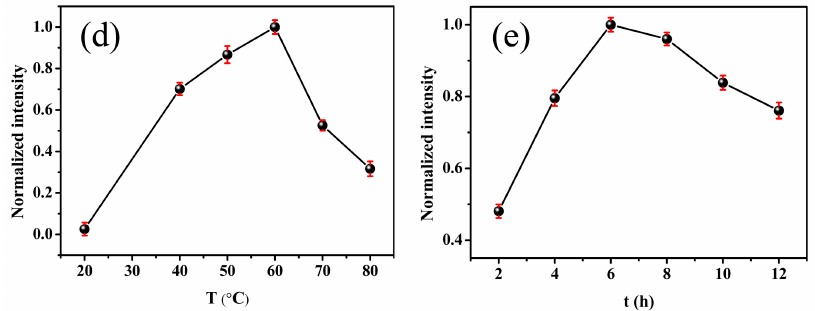
Figure 1. The influence of the concentration of methionine ( a ); the concentration of NaOH ( b ); the concentration of ascorbic acid ( c ); the reaction temperature ( d ); and time ( e ) on the fluorescence intensity of Pd NCs.